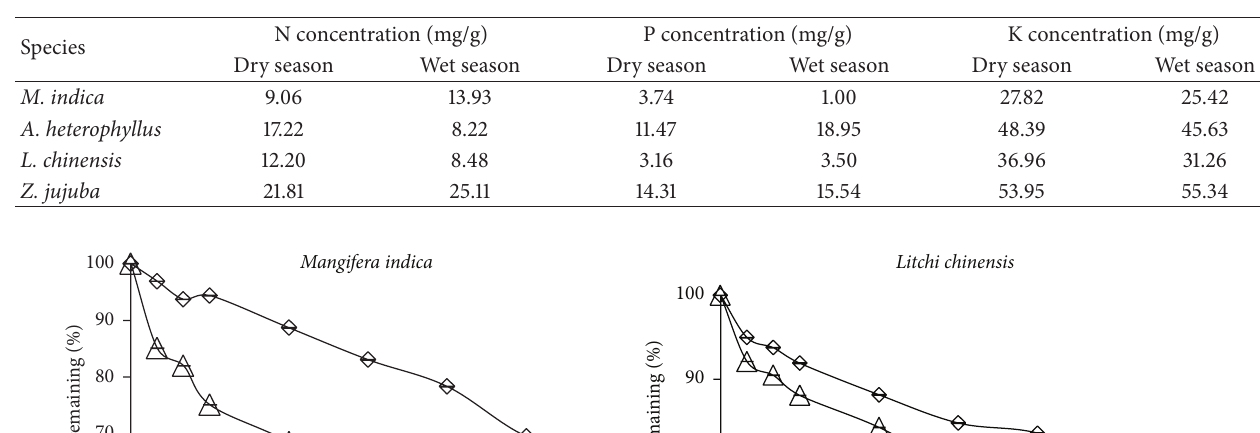
Table 7: Nutrients added through microbial decomposition of leaf litter of cropland agroforest horticultural tree species in dry and wet season.